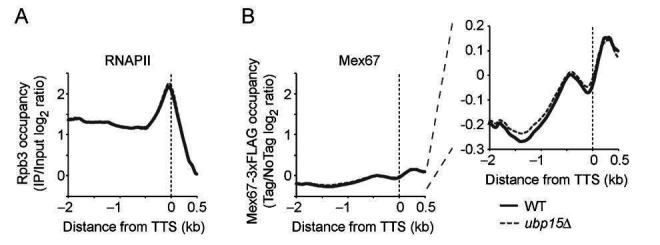
Mex67 occupancy on active genes is not affected by the deletion of UBP15.A) RNAPII (Rpb3) occupancy, as determined by ChIP-chip, over genes longer than 1 kb and with an average RNAPII occupancy (log2 ratio) over 1 (n=234), in WT and ubp15Δ cells. B) Mex67-3xFLAG occupancy, as determined by ChIP-chip, over genes longer than 1 kb and with an average RNAPII occupancy (log2 ratio) over 1 (n=234), in WT and ubp15Δ cells. The left panel displays the data using the same y-axis as panel A, while the right panel shows a zoom into the -0.3-0.2 log2 ratio range.